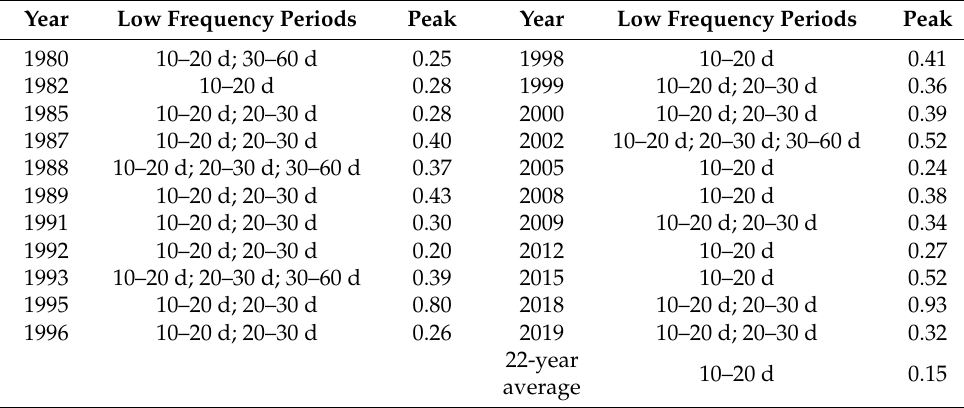
Table 2. The significant low frequency periods of the regional average minimum temperature in northern China in 22 winters when RSCEs occurred (the periods in question pass the significant test at α = 0.1 level) and the significant peaks of each